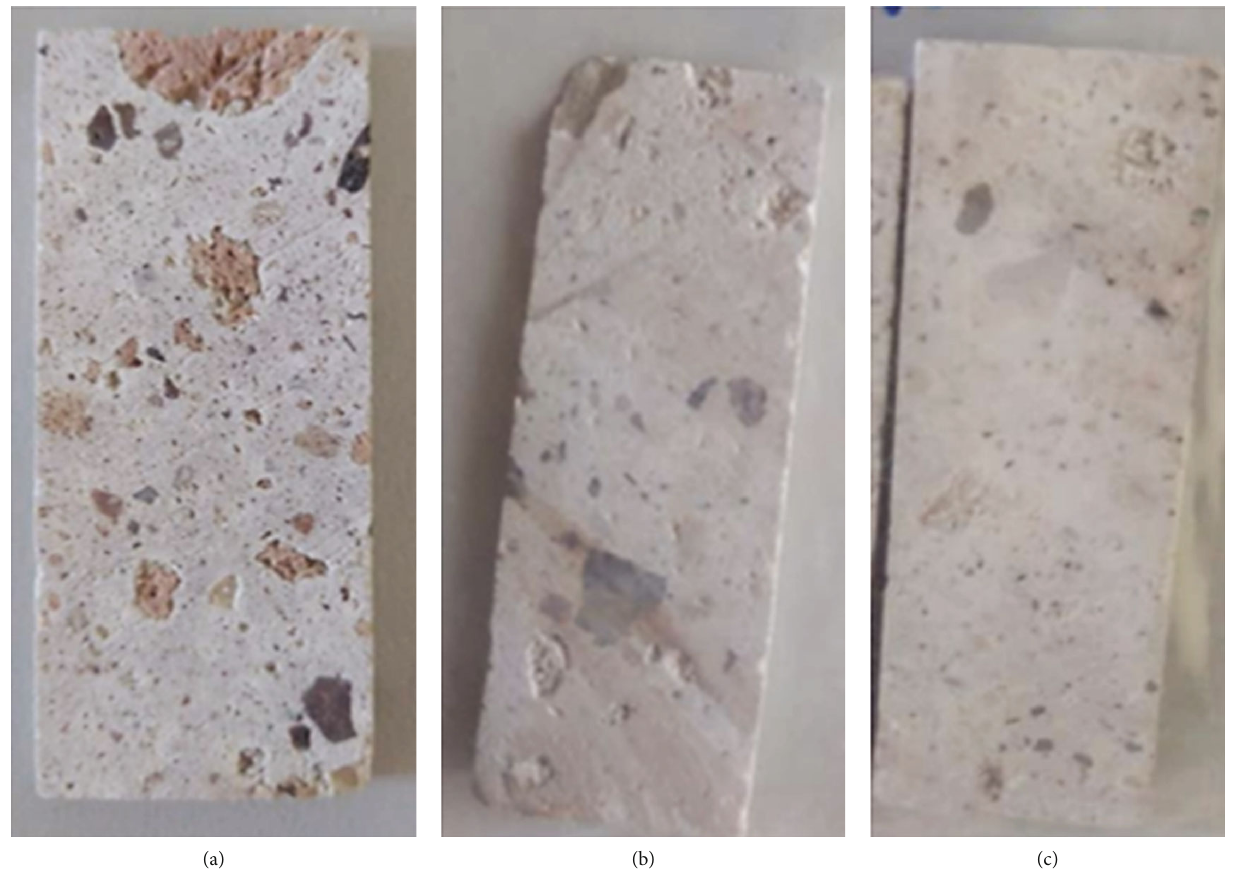
Figure 1: Photographs of (a) ignimbrite, (b) 10TEOS-5TiO